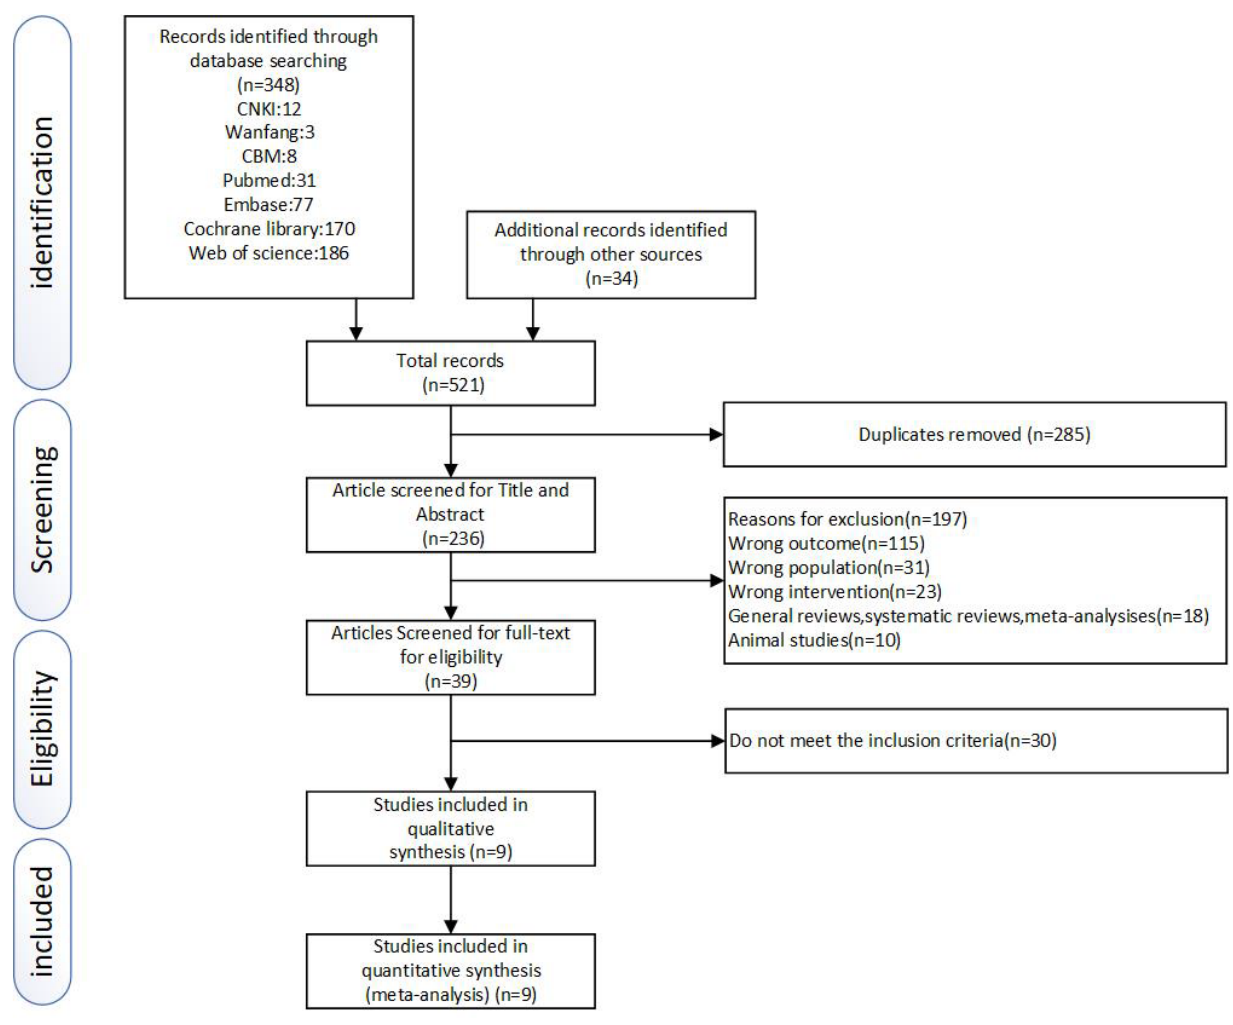
Figure 1. Literature search and study selection process.